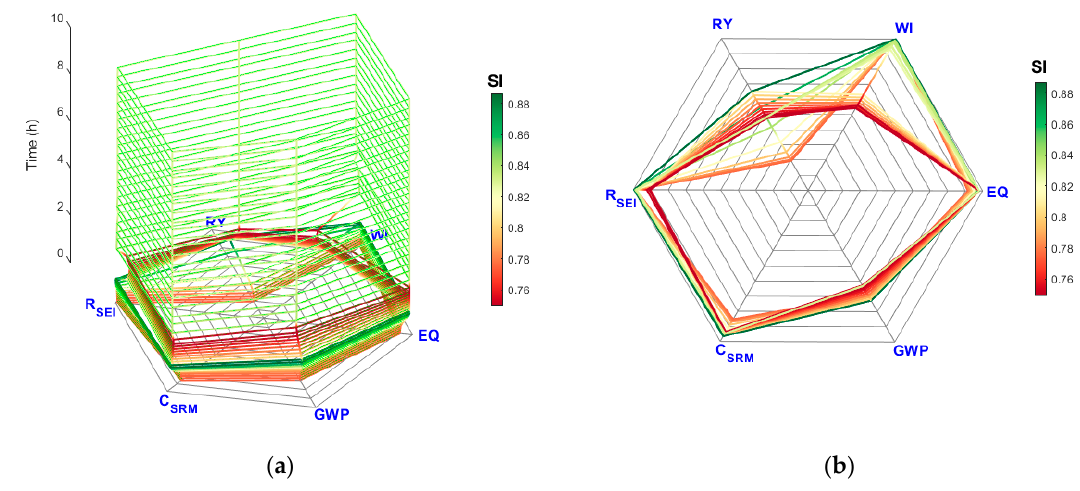
Figure 7. Case 1—dynamic sustainability performance without sustainability constraint: ( a ) 3D sustainability indicator dynamic radar plot; ( b ) 2D projection of sustainability indicator radar plot.